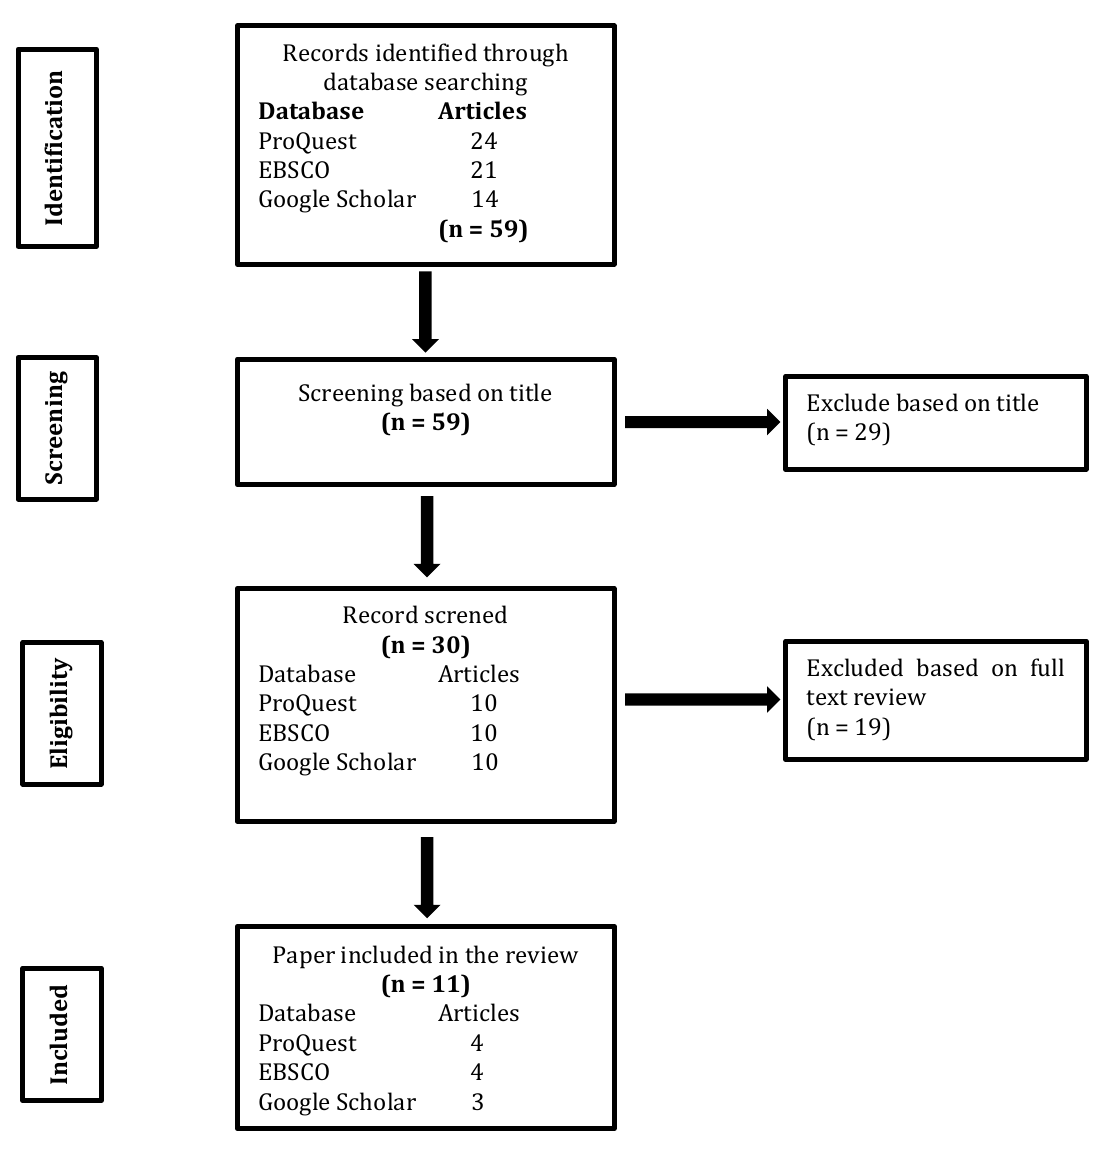
Figure 1 . Flow diagram of the results of the article selection